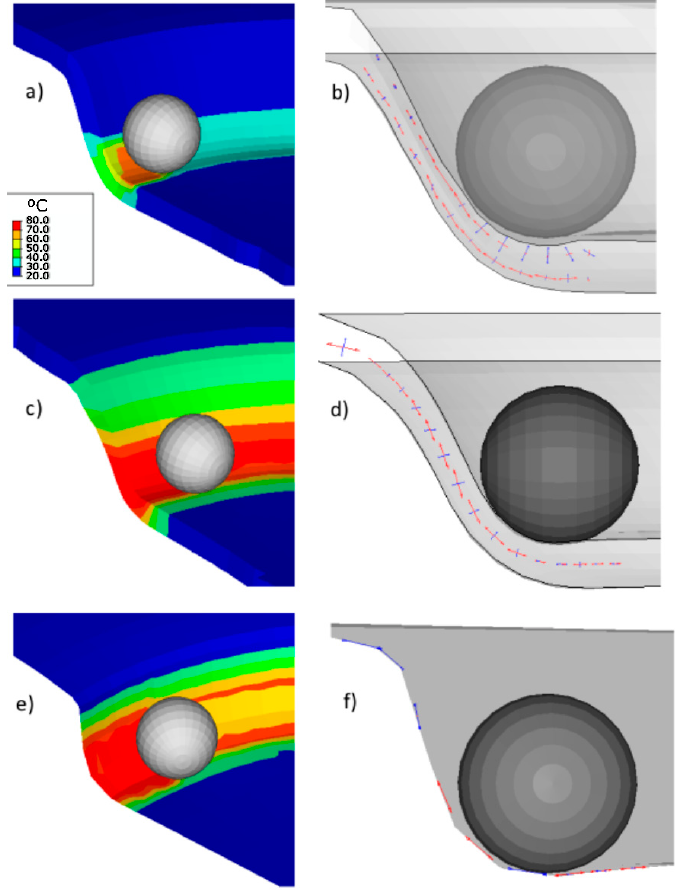
Figure 9. Deformation mechanism. Temperature (left), and strain (right) distribution at z = 15 mm for di ff erent element types. C3D8RT ( a , b ), SC8RT ( c , d ) and S4RT ( e , f ).